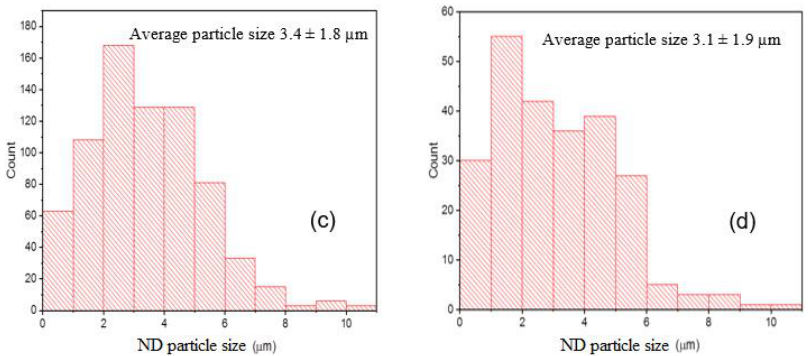
Figure 4. Optical micrographs ( a , b ) and particle size distributions ( c , d ) for the non-imprinted and molecularly imprinted polymers, respectively.